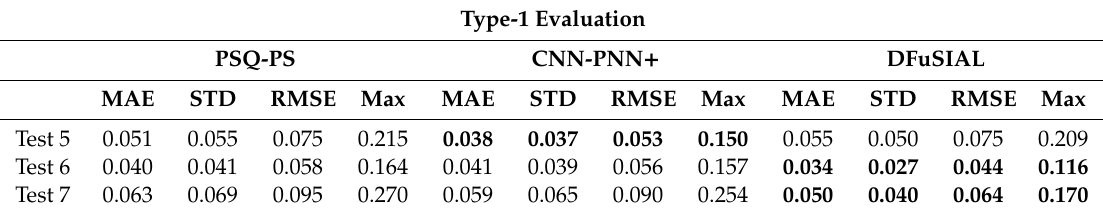
Table 4. Type-1 evaluation of fraction values, obtained in Experiment 2 (Tests 5–7) by PSQ-PS, CNN-PNN + , and the proposed fusion method DFuSIAL, with respect to the obtained fractions, in HSR by